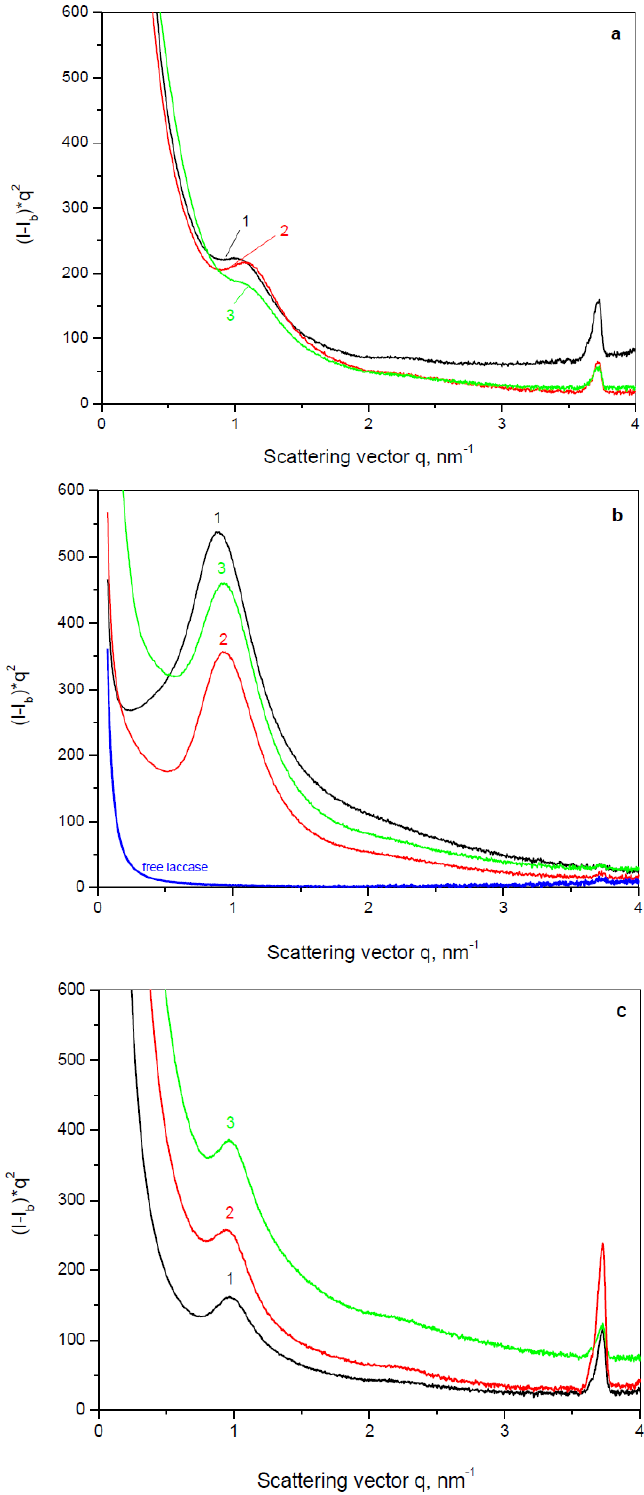
Figure 9. Linear SAXS patterns of: ( a ) empty PA4 supports; ( b ) PA4@iL and ( c ) PA4@eL samples. 1—PA4; 2—PA4-FE; 3—PA4-Fe 3 O 4 supports. The laccase pattern is presented in Figure 9b for comparison.